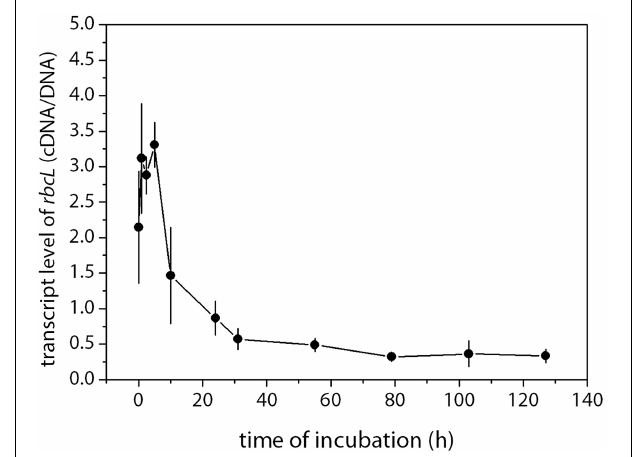
FIGURE 7 | Abundances of rbcL (cDNA) normalized to the gene copy number (cDNA/DNA) during the incubation. The transcription level of the genes was the cDNA gene copies standardized by the DNA gene copies in samples taken at the same time point. Mean values ( ± SD) are the average of four independent